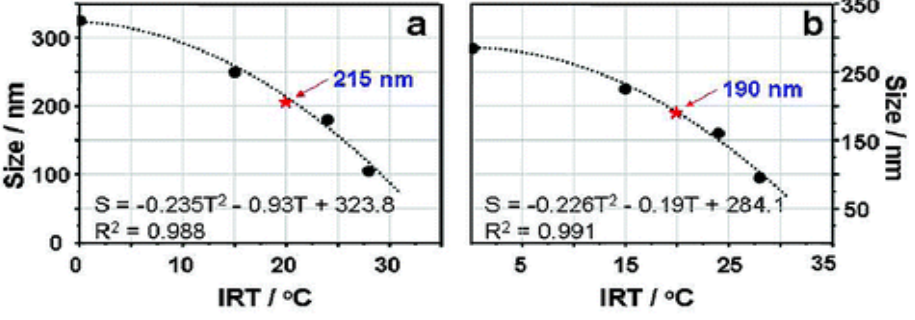
Figure 18. Nanosphere size as it relates to IRT for nanospheres before ( a ) and after ( b ) carbonization (reproduced from the work in [64] with